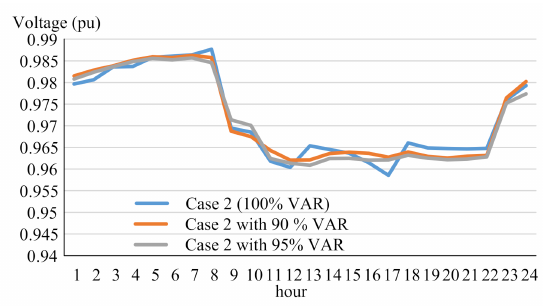
Figure 11. The VAR of daily minimal voltage in the various confidence